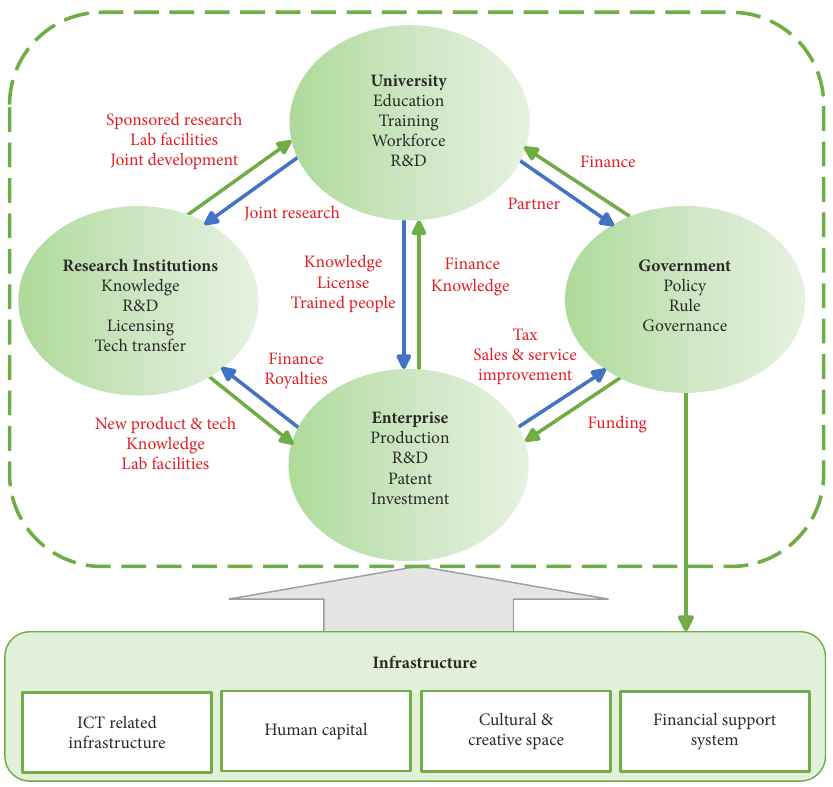
Figure 1. Regional innovation system model for special municipalities in